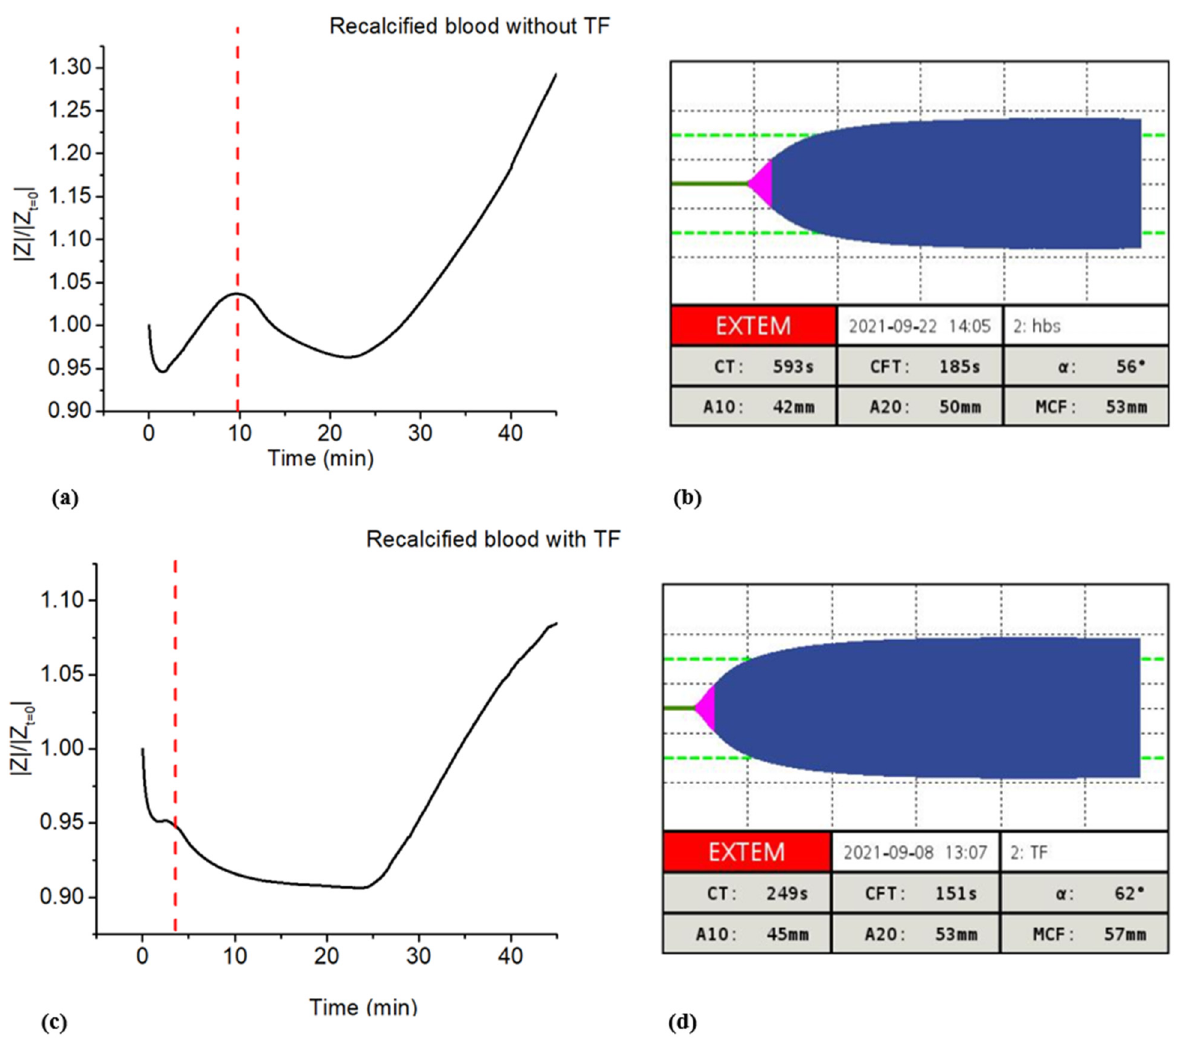
Figure 8. ( a ) Impedance-magnitude test and ( b ) ROTEM ® analysis of recalcified blood from the same donor without TF. ( c ) Impedance-magnitude test and ( d ) ROTEM ® analysis of recalcified blood from the same donor with TF.